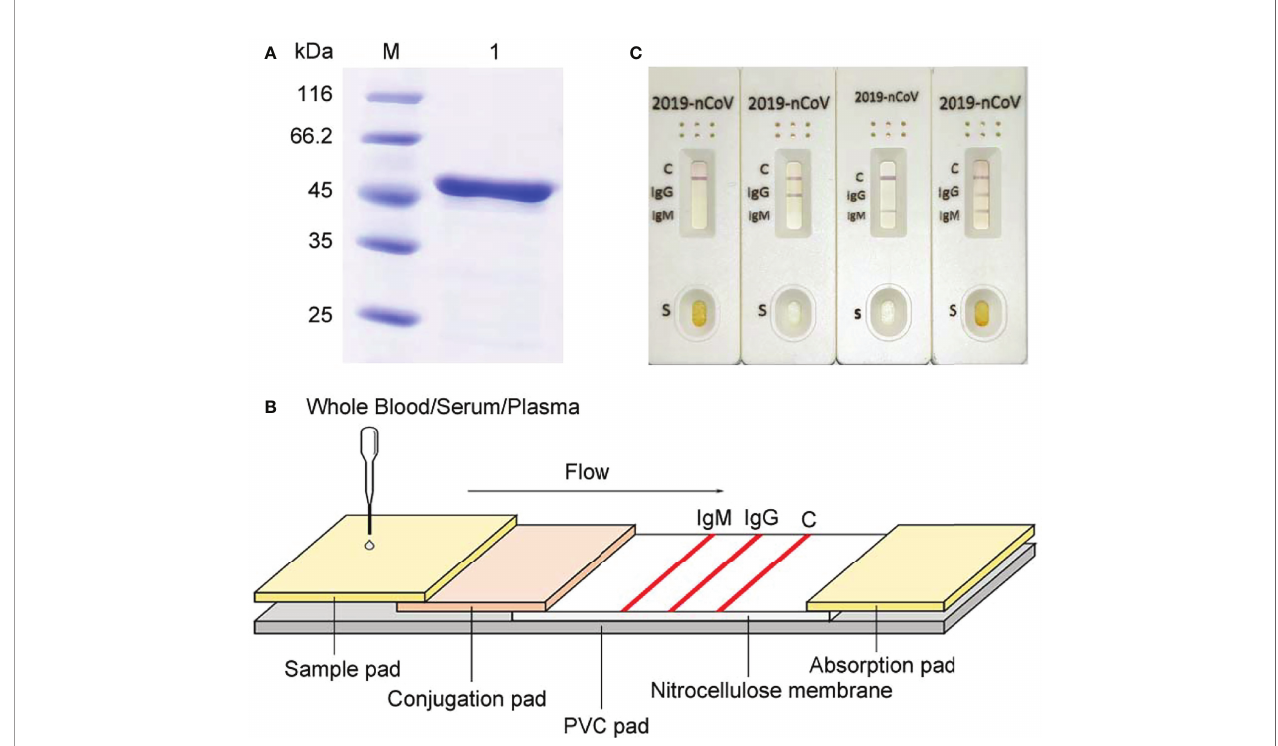
FIGURE 1 | Development of our rapid SAR-CoV-2 antibody test (ALLtest). (A) Puri fi cation of COVD-19 nucleocapsid. M: markers; 1: recombinant SARS-CoV-2 nucleocapsid. (B) Schematic illustration of ALLtest. (C) Typical testing results of ALLtest (from left to right: negative, IgG positive, IgM positive, IgG&IgM